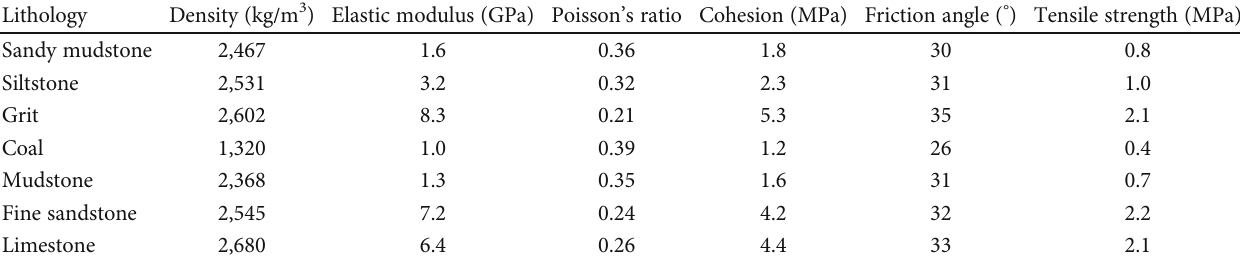
Table 1: Physicomechanical parameters of rock